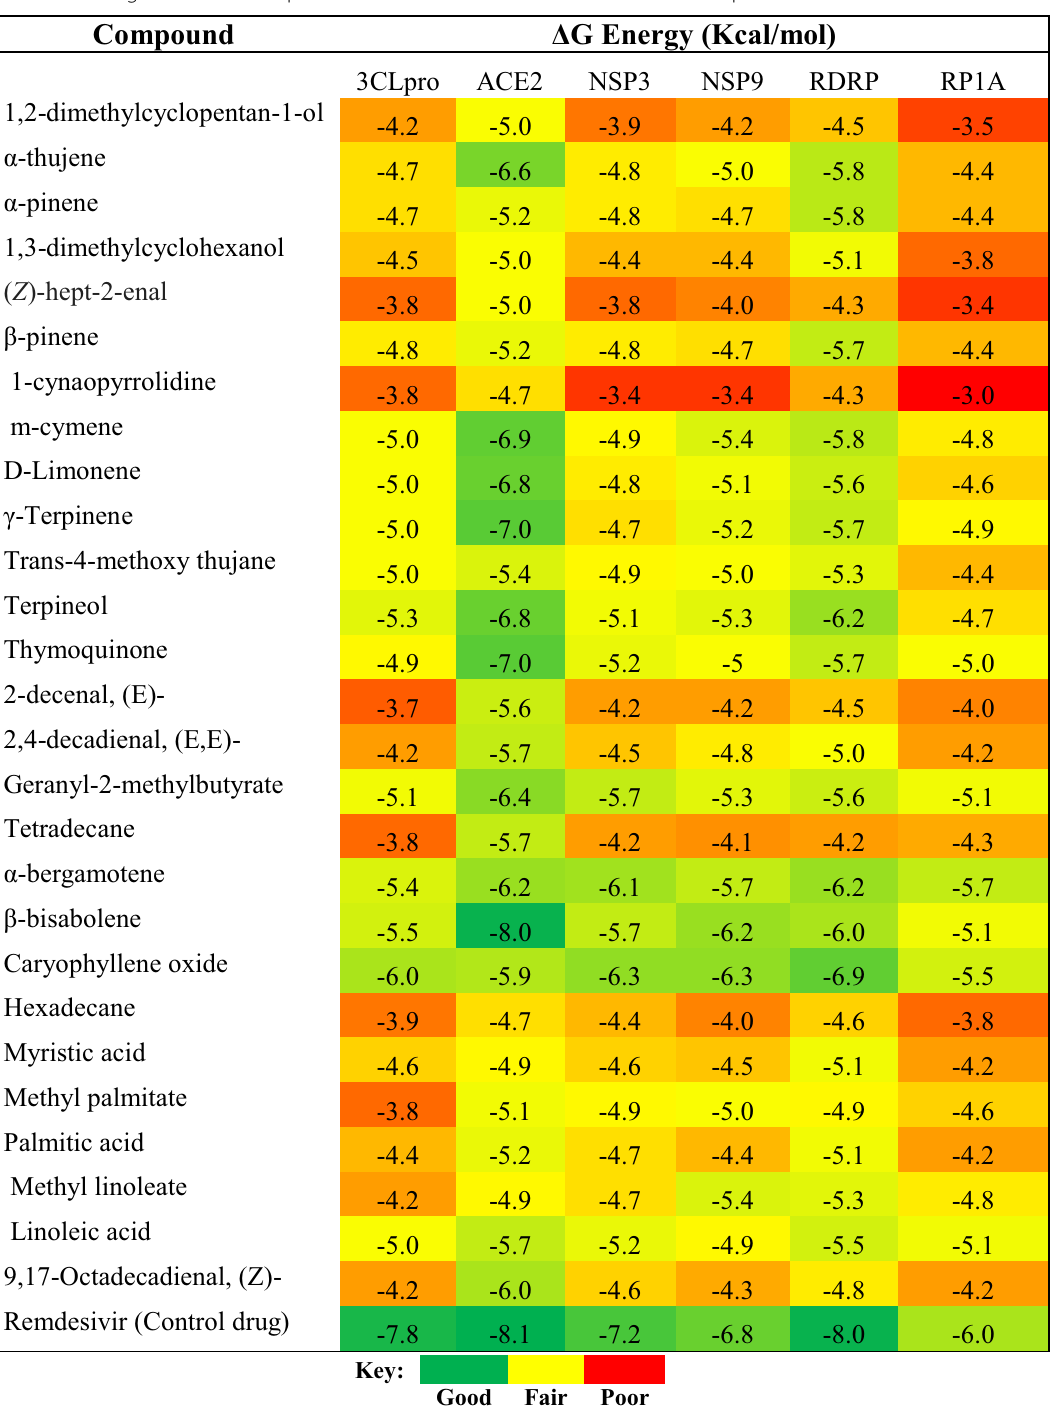
Table 2 Binding affinities of compounds in the oil of N. sativa seed for SARS-CoV-2